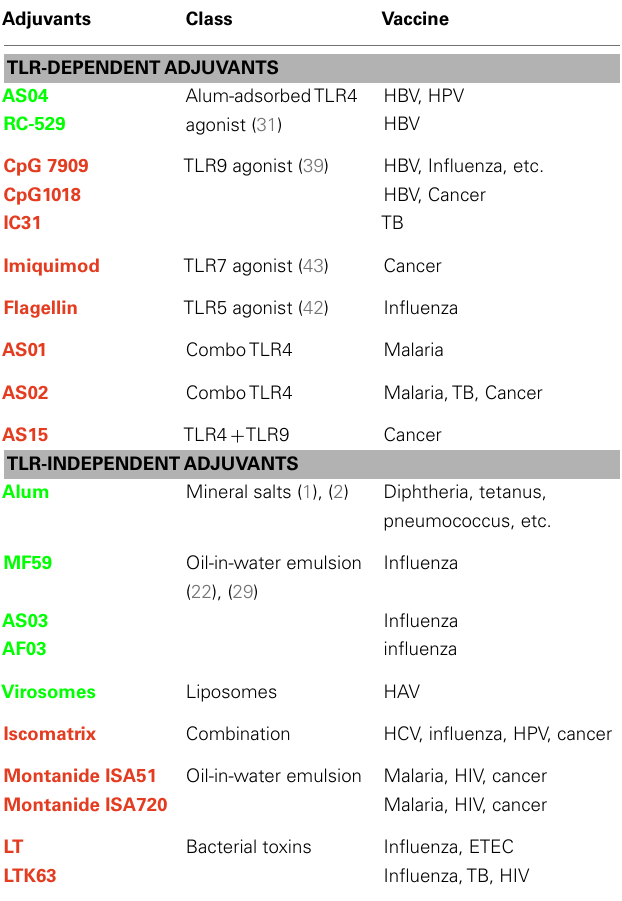
Table 1 |Adjuvants evaluated in